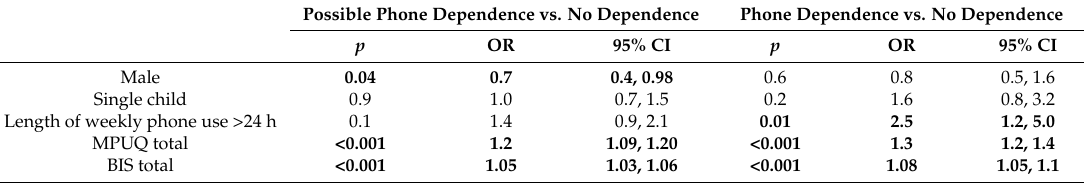
Table 2. Factors independently associated with phone dependence (multinomial logistic regression analysis with no dependence as the reference